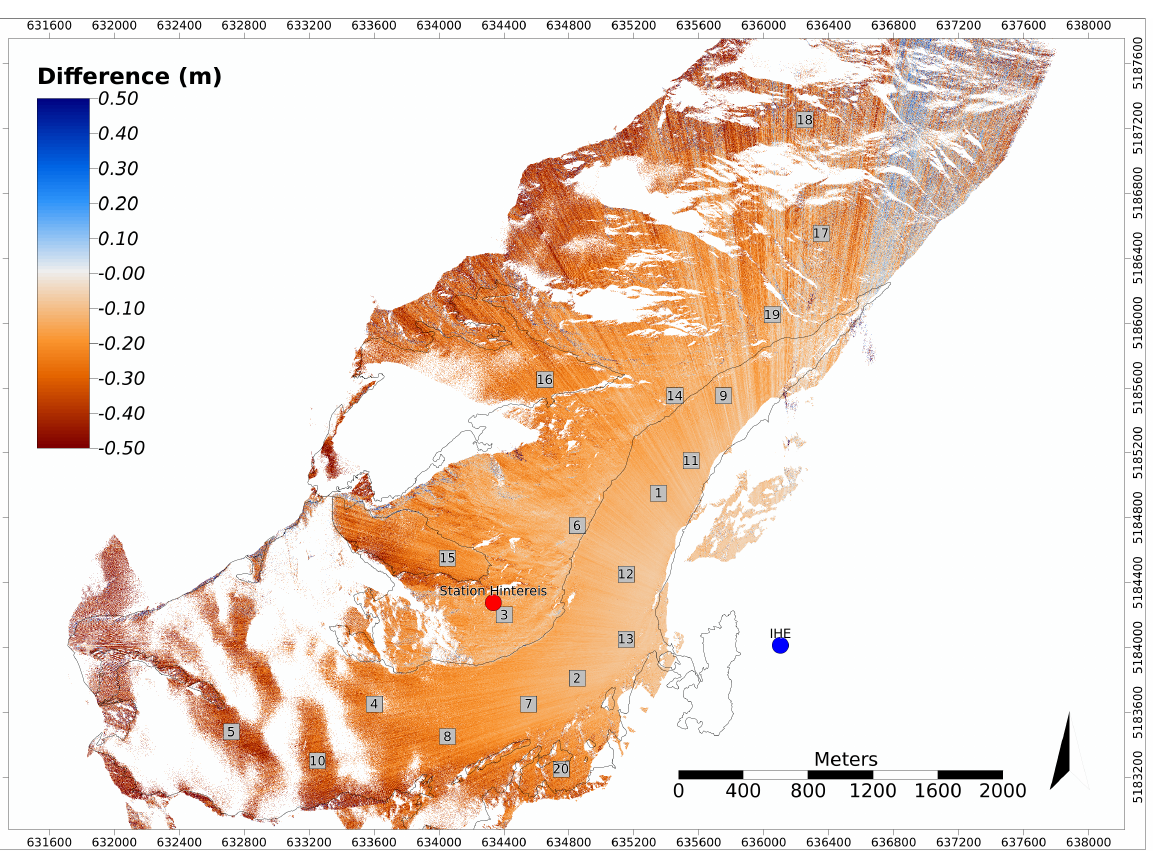
Figure 1. Plot of the apparent difference between the scan of 5 November 10:55 and 12:13 UTC. The blue dot (IHE) is the location of the TLS and the red dot is the location of Station Hintereis. The numbered grey squares indicate the position of the 20 test areas used in Sect. 3.2. The black lines are the glacier outlines as measured in